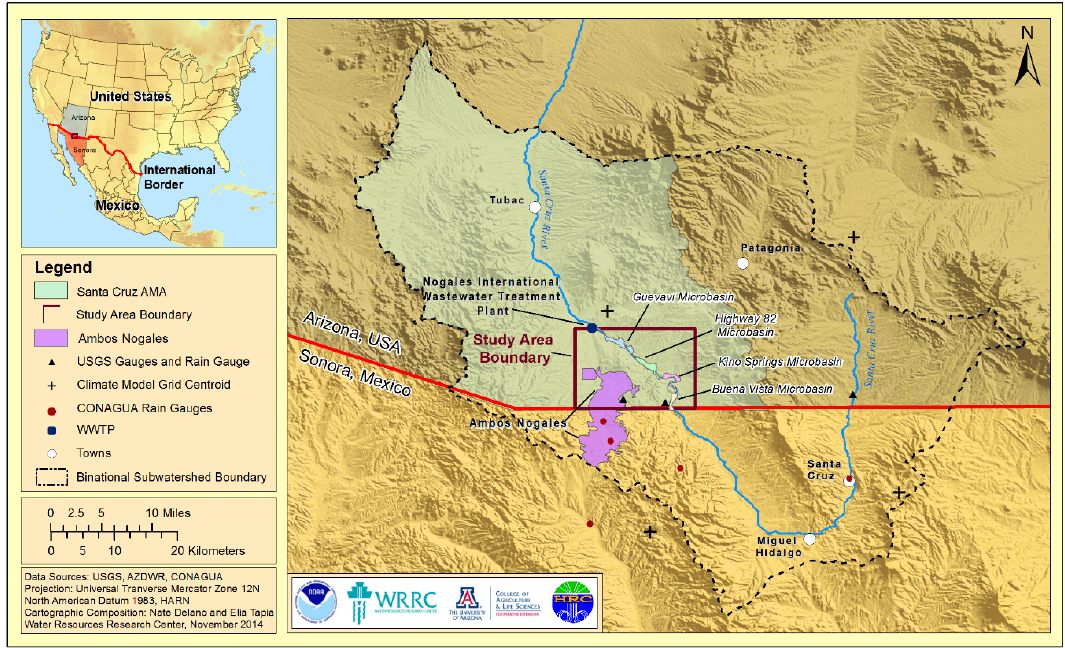
Figure 1. Map of case study area. Nogales, Arizona and Nogales, Sonora are collectively refered to as “Ambos Nogales”.